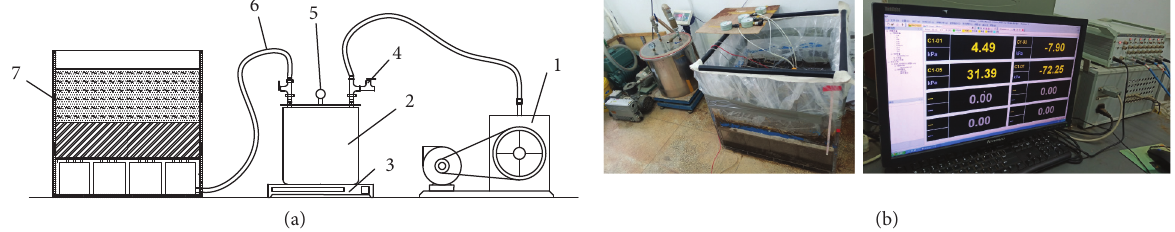
Figure 4: Rapid sludge dewatering system with a vacuum negative pressure load at the bottom of the full section. (a) Schematic diagram of test model system. 1, vacuum pump; 2, gas-water separator; 3, electronic scale; 4, valve; 5, vacuum gauge; 6, connecting pipe; and 7, model box. (b) Test model